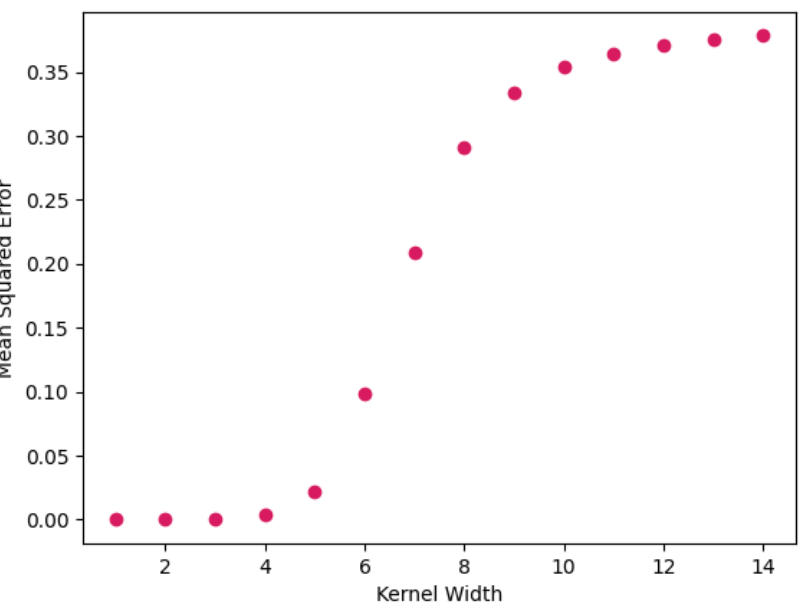
Figure 10. As the kernel width parameter increases, so does the mean square error.